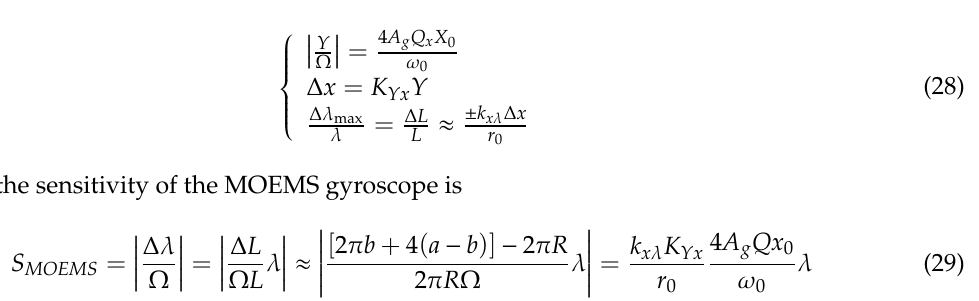
Figure 14. The output of the MOEMS gyroscope in linear and nonideal conditions. (4) Cross-Axis Coupling and Equivalent Signals In the gyroscope, due to fabrication imperfections disrupting the isotropy of the MEMS disk resonator, causing frequency mismatch and mode coupling [20] , we consider the cross-axis coupling. Equation (1) can be re-written as